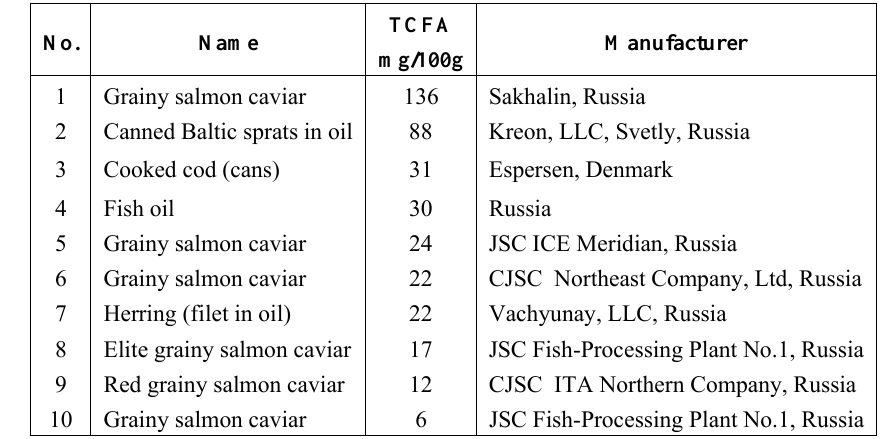
Table 4. Total Content of Fat-Soluble Antioxidants (TCFA) in Seafood Products (standard – quercetin).